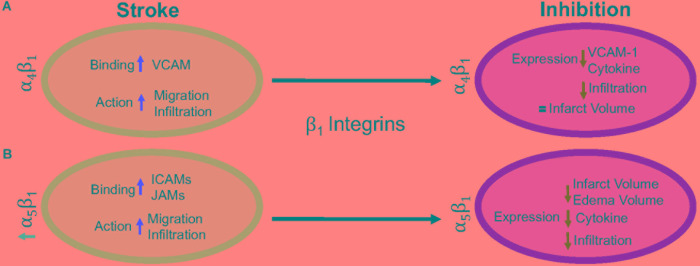
Representative image of the β1 integrin response following experimental stroke and inhibitory antibody treatment in preclinical trials. Inhibition of (A) α4β1 and (B) α5β1 integrins post-stroke responses and effects.